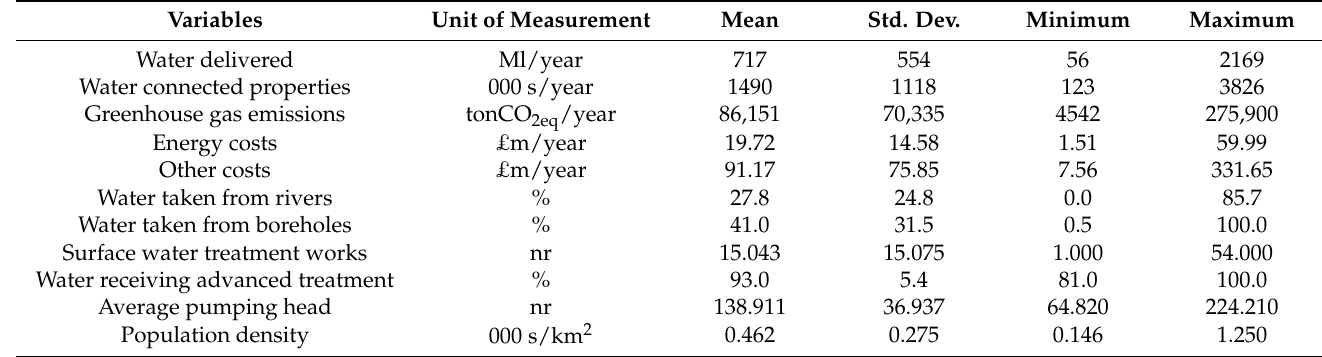
Table 1. Descriptive